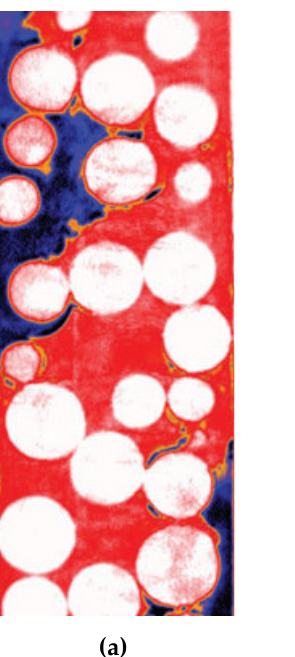
Figure 4. Examples of reconstructed (X-ray Skyscan 1174 data) sectional slices for the entire length of the column obtained after 10 days at a flow rate of approximately: ( a ) Q = 0.07 mL·s − 1 ; ( b ) Q = 0.5 mL·s − 1 (a pseudocoloration has been applied to the images using ImageJ on the basis of the ceretec LUT and only for visualization purposes). The whitened parts correspond to the beads, the red parts to the biofilm and the dark blue parts to the aqueous phase [75].